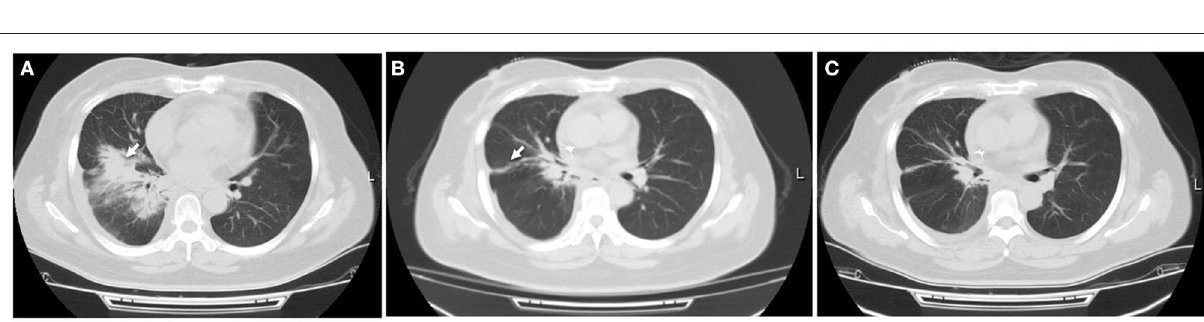
FIGURE 1 | Time axis of anti-tumor treatment and intervention on pneumonitis. Line graph illustrating disease progression, anti-tumor therapy, pneumonitis and intervention from April 2018 to August 2019. IVIG, Intravenous immunoglobulin; SVCS, Superior vena cava obstruction syndrome.